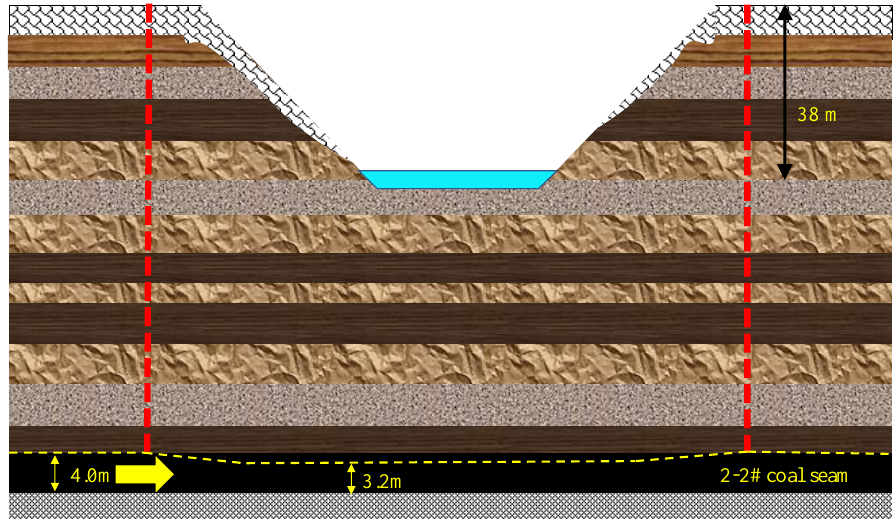
Figure 7. Mining scheme of reducing mining height for P101.